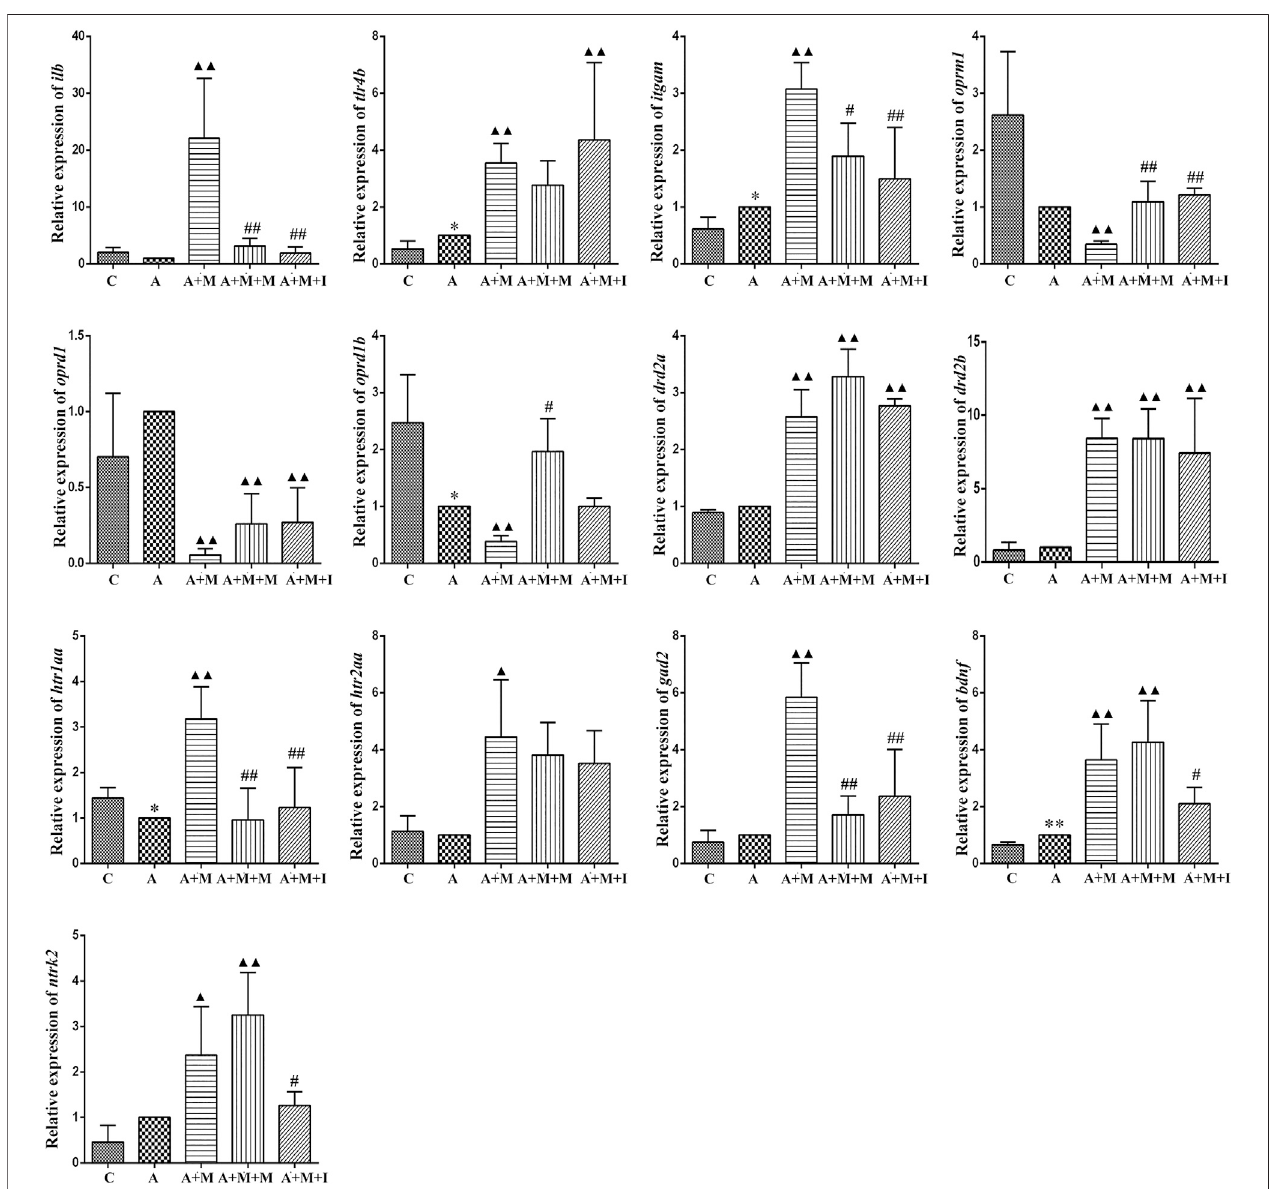
FIGURE15| qPCRanalysisof il1b , tlr4b , itgam , oprm1 , oprd1 , oprd1b , gad2 , drd2a , drd2b , htr1aa , htr2aa , bdnf ,and ntrk2 expressioninthezebra fi shgut( n (cid:2) 3). * p < 0.05,** p < 0.01 vs thecontrolCgroup; # p < 0.05, ## p < 0.01 vs theA+Mgroup; ▲ p < 0.05, ▲▲ p < 0.01 vs theAgroup.C:controlgroup;A:antibioticgroup;A+M: antibiotic + morphine group; A + M + M: antibiotic + morphine + methadone group; A + M + I: antibiotic + morphine + isorhynchophylline group.